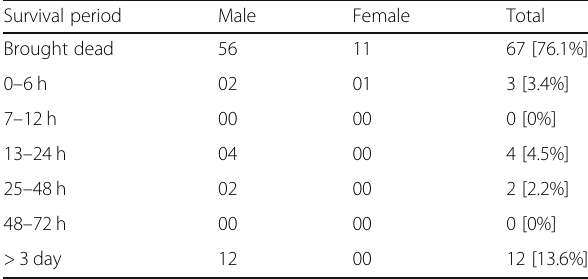
Table 8 Survival period of victims of electrocution Survival period